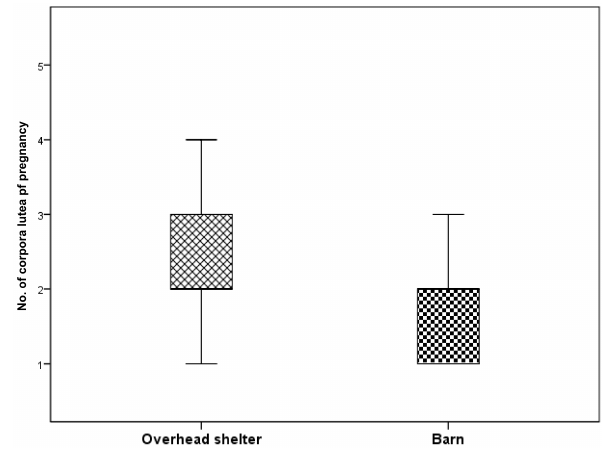
Figure 1. The distribution of corpora lutea in two successive estrus cycles.